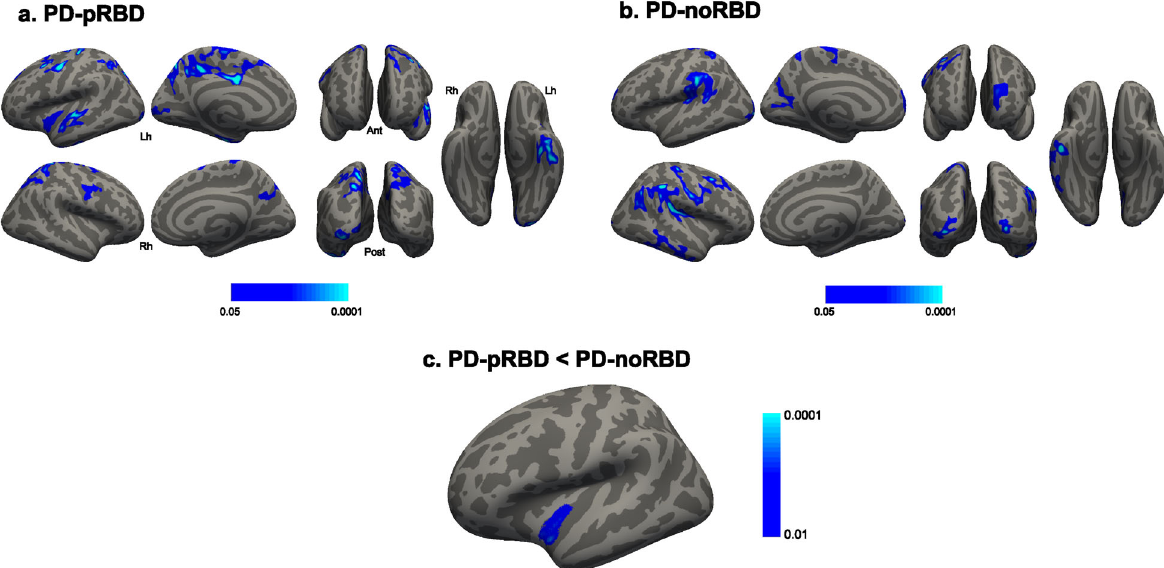
Fig. 2 Longitudinal changes in cortical thickness. The symmetrized percent change (SPC) over 2 years of cortical thickness in ( a ) PD patients with probable RBD (PD-pRBD), ( b ) PD patients without RBD (PD-noRBD), ( c ) and the difference between two groups. The PD-pRBD group revealed a signi fi cantly increased rate of cortical thinning in the left insular cortex compared with the PD-noRBD group. The color scale bars show the p -values. Lh, left hemisphere; Rh, right hemisphere; Ant, anterior; Post, posterior.